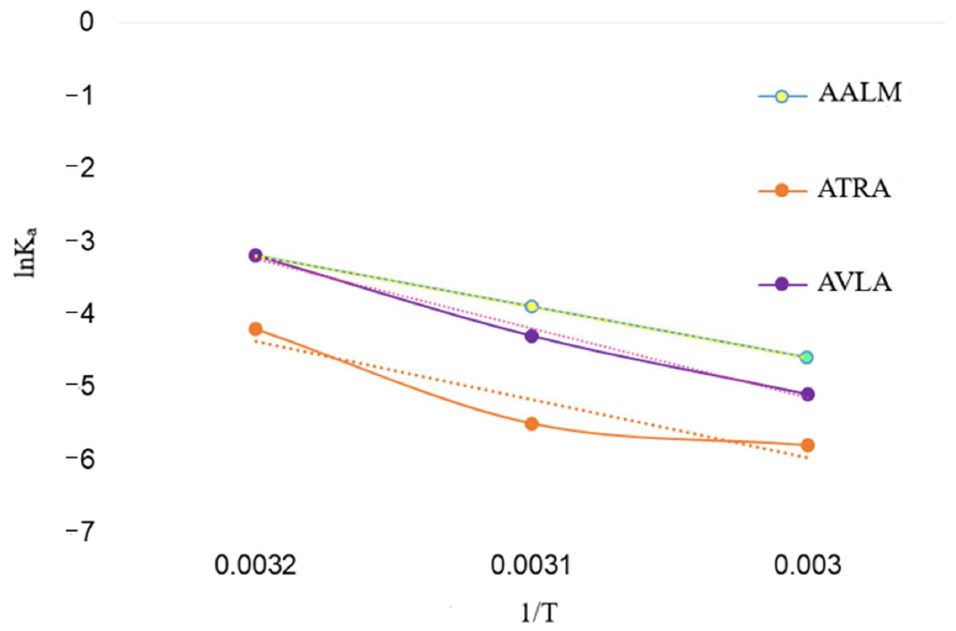
Figure 6. Kinetics of PPL fluorescence quenching: Plot shows relationship between interaction (K a ) of extracts and temperature (lnK a vs. 1/T).